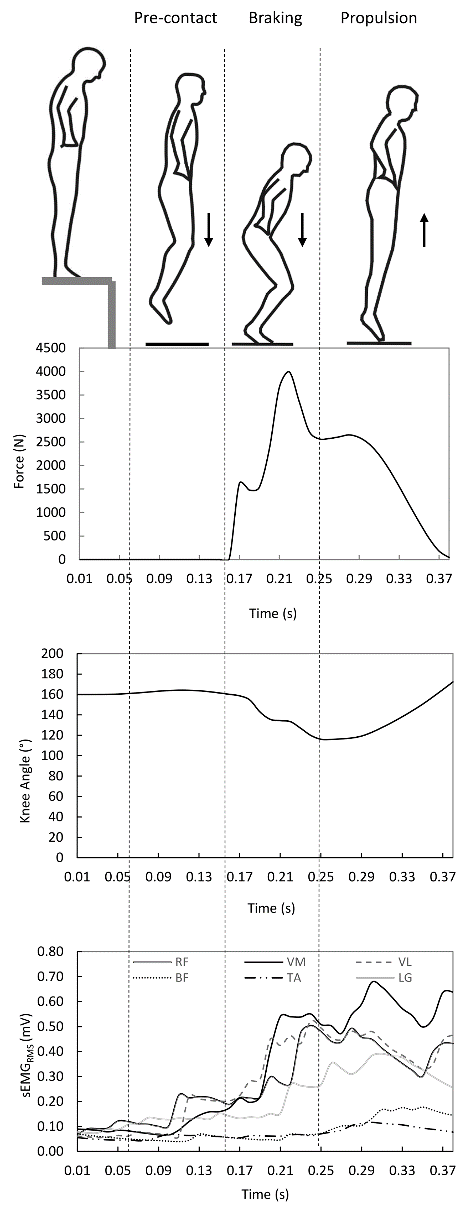
Figure 1. Schematic representation of the time histories of ground reaction force and knee angle displacement during the three phases of the drop jump (pre-contact, braking and propulsion). The surface-electromyography root-mean-square (sEMG RMS ) of the vastus lateralis (VL), rectus femoris (RF), vastus medialis (VM), biceps femoris (BF), tibialis anterior (TA) and lateral gastrocnemius (LG) muscles was synchronized with the other two variables.